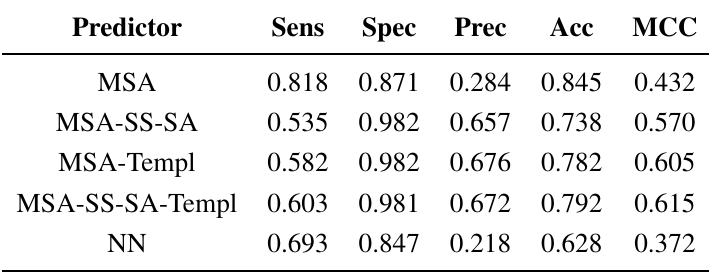
Table 2. Results of Sensitivity (Sens), Specificity (Spec), Precision (Prec), Accuracy (Acc) and MCC on the test set for all of our systems.